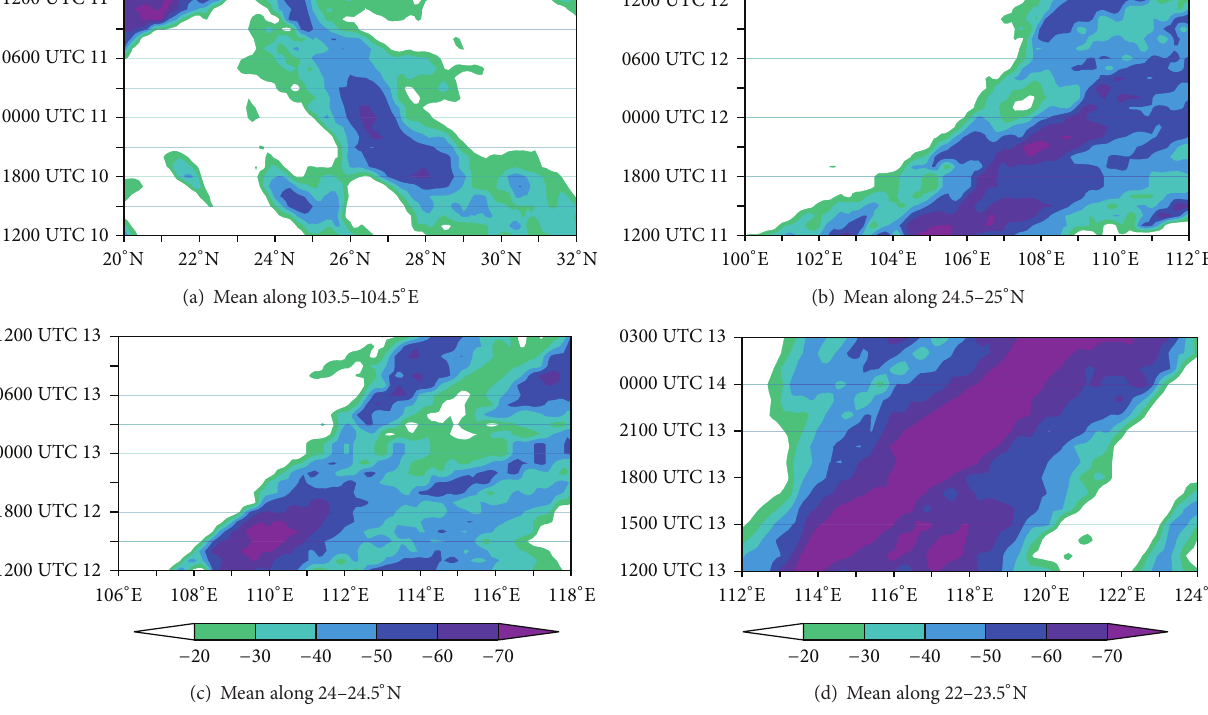
Figure 12: Temporal sections of black body temperature (TBB) of the SWV cloud system in the unit of ∘